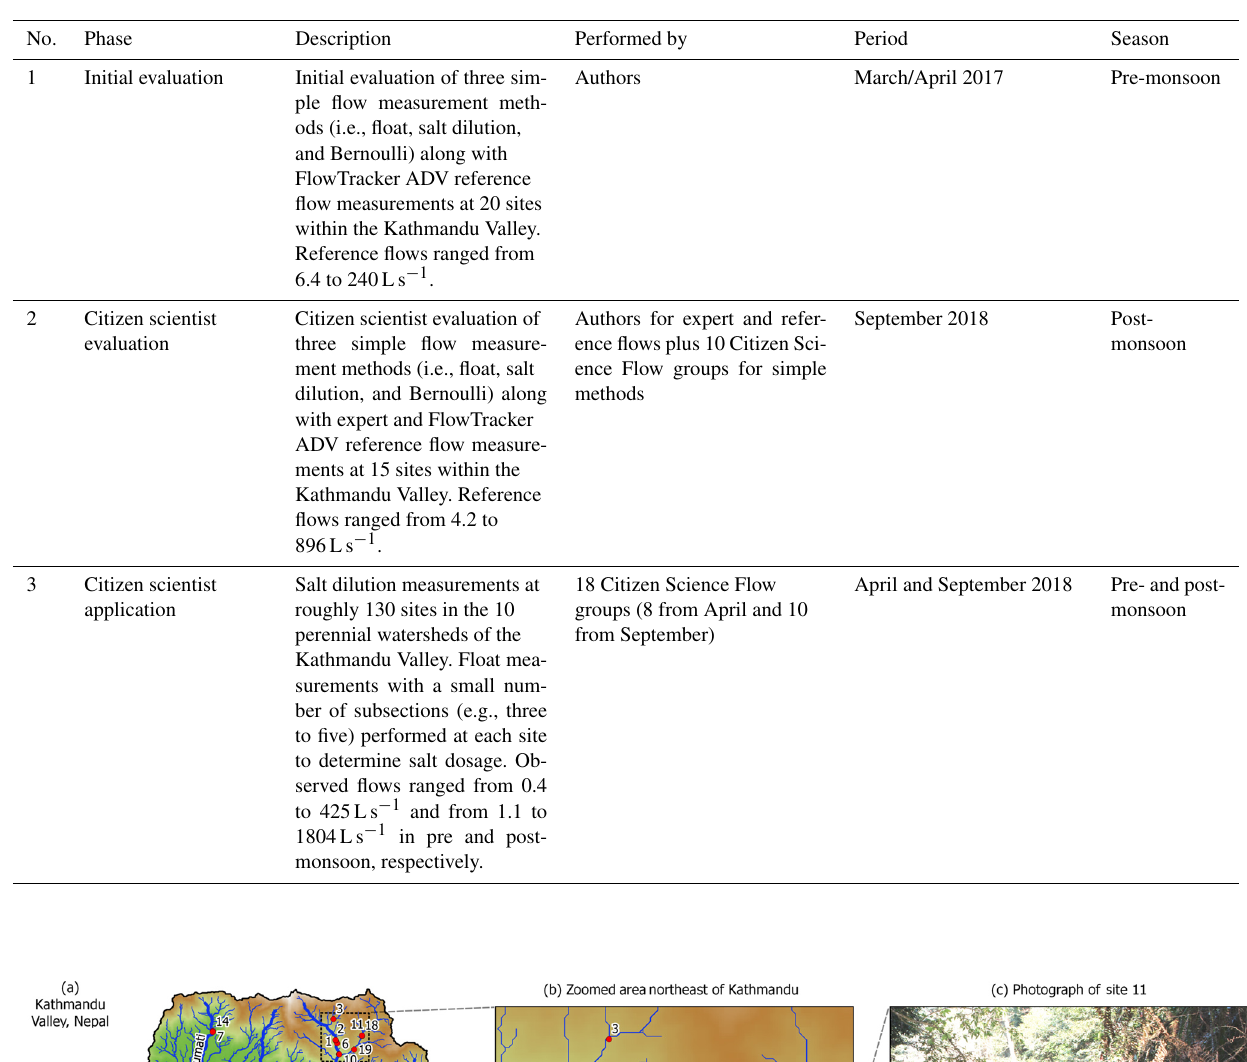
Table 2. Brief descriptions of three data collection phases including who performed the field data collection and what period and season the data were collected in.